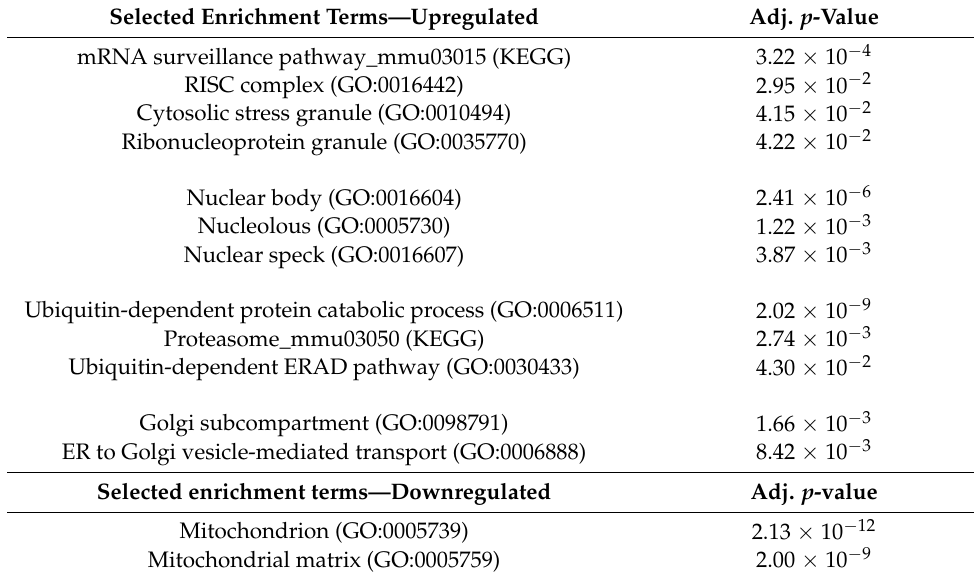
Table 1. Gene expression changes indicate the activation of proteostasis mechanisms in A226Y liver. Curated gene enrichment list comparing A226Y and WT liver; FDR-adjusted p -values shown. Selected Enrichment Terms—Upregulated Adj. p